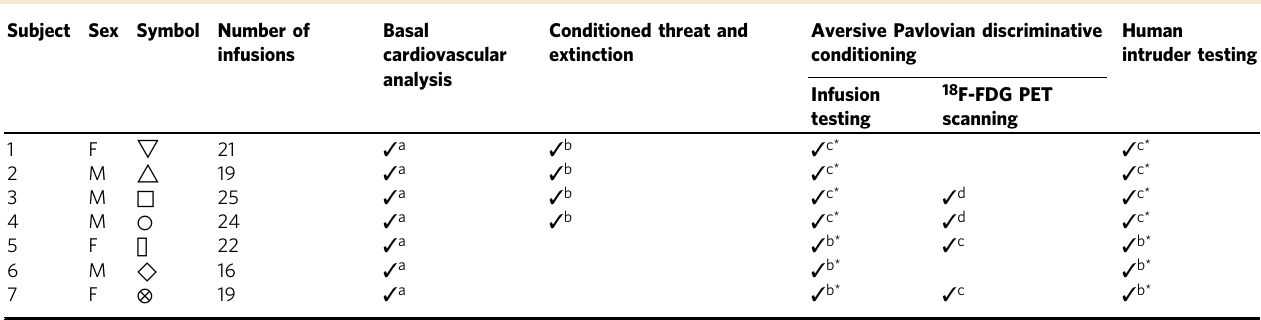
A tick indicates that the subject took part in that phase of the study, with letters a – d denoting the order of testing. A star (*) indicates parallel testing phases. See Methods for full explanation of why not all animals were tested in all conditions. F female, M